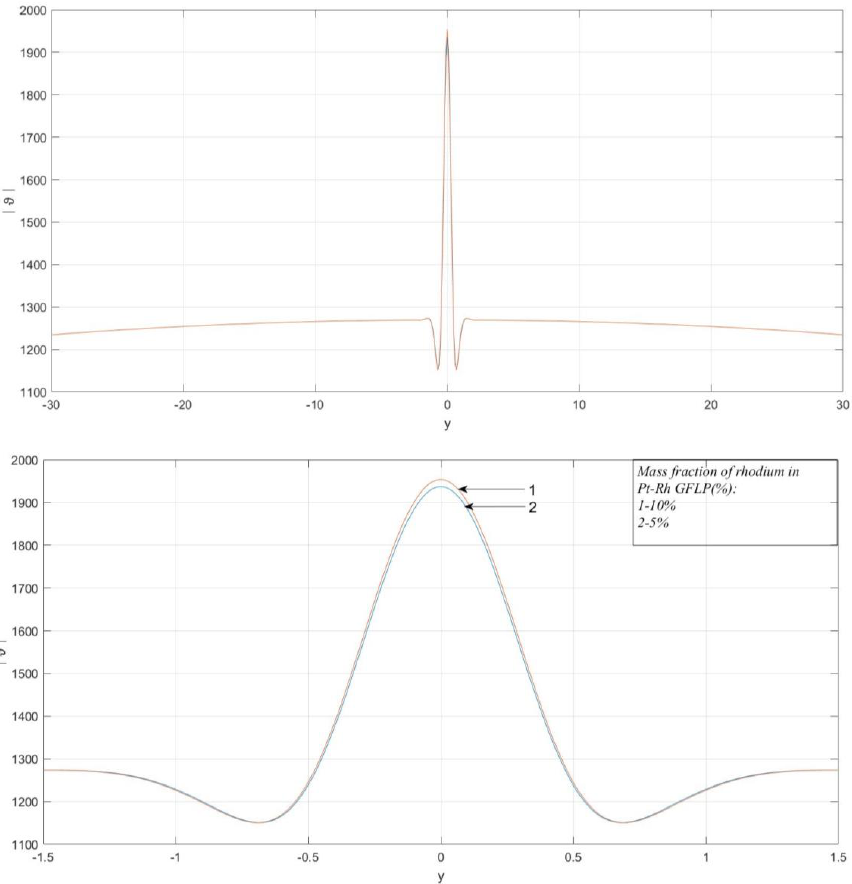
opening of Pt–Rh Figure 3. ( a ) Temperature near the circular opening of Pt–Rh GFLP, ( b ) Temperature near the circular opening of Pt–Rh GFLP.